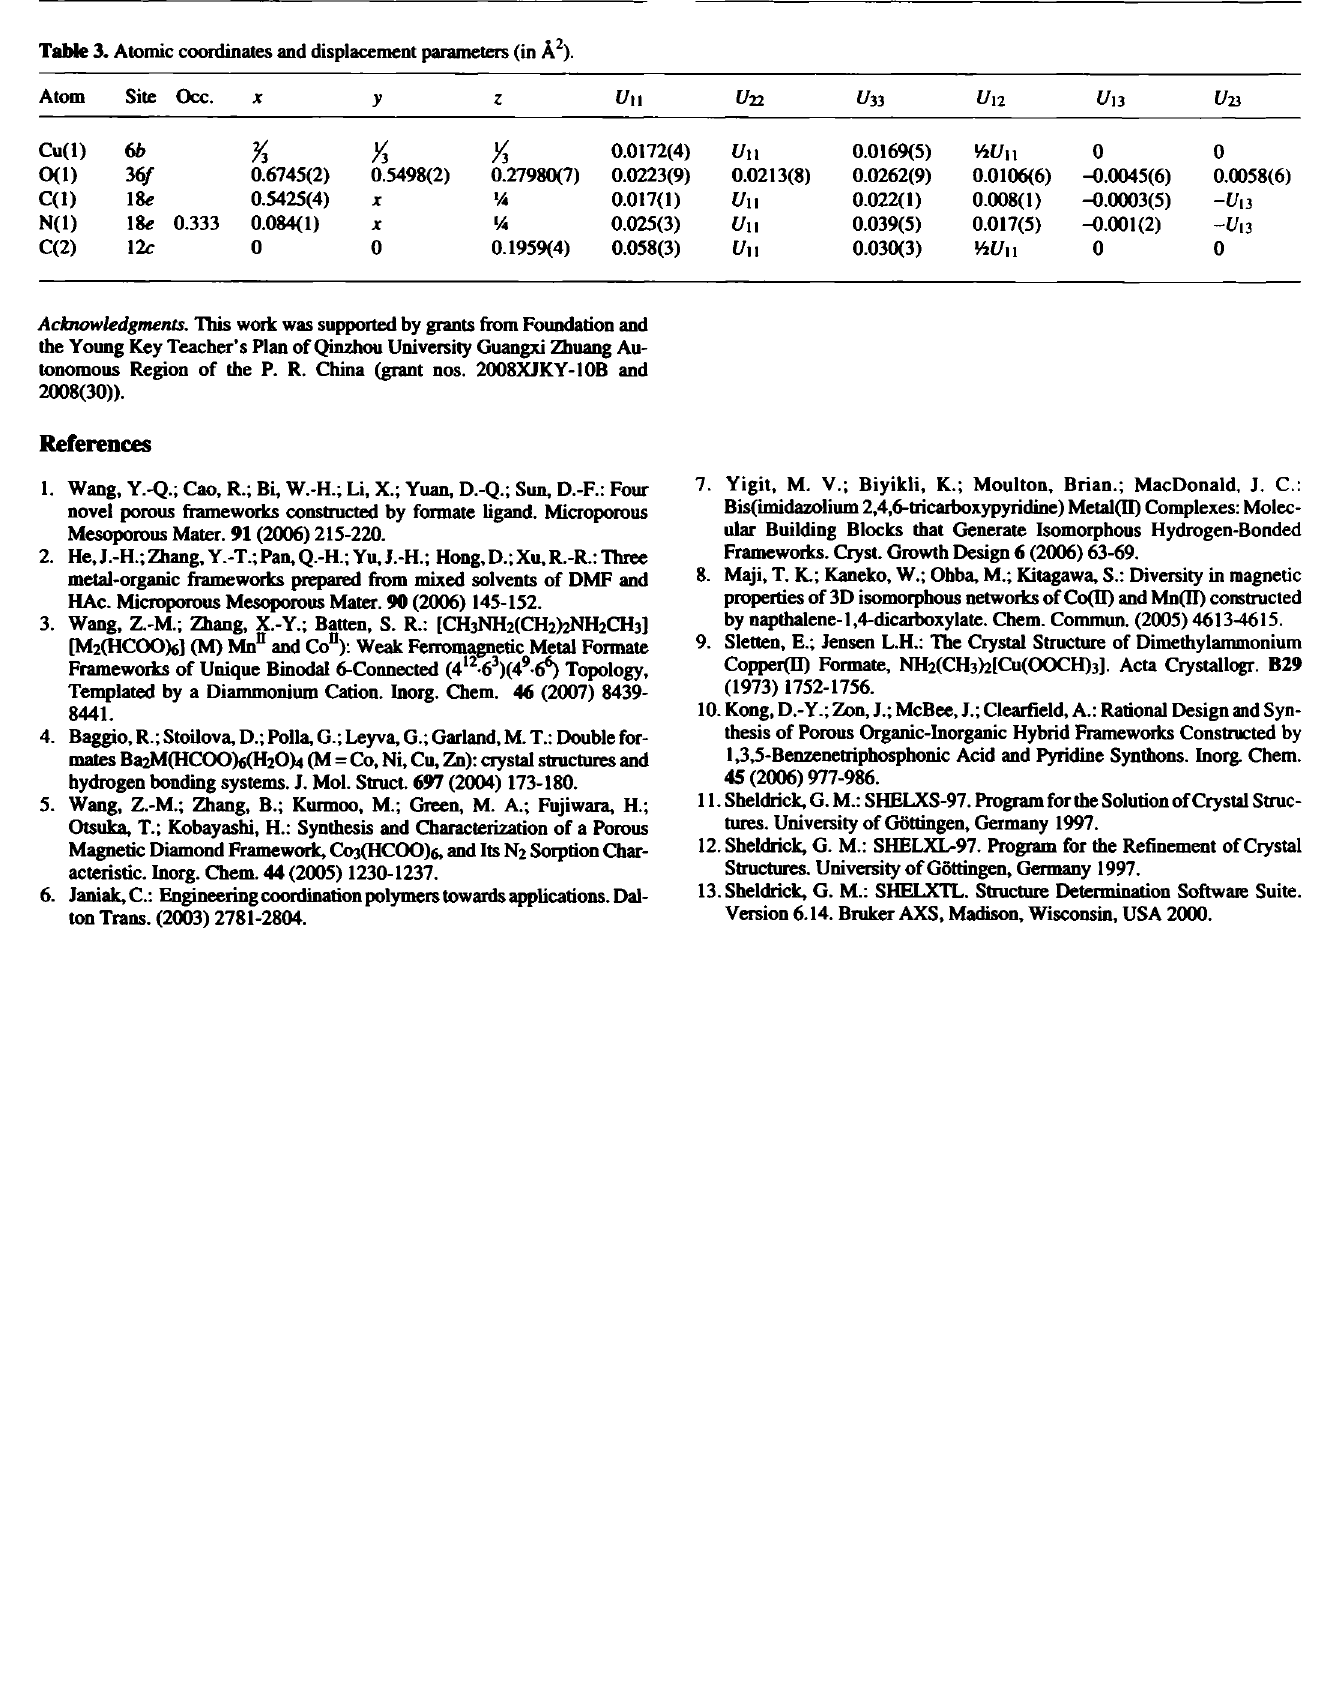
Table 3. Atomic coordinates and displacement parameters (in Â 2